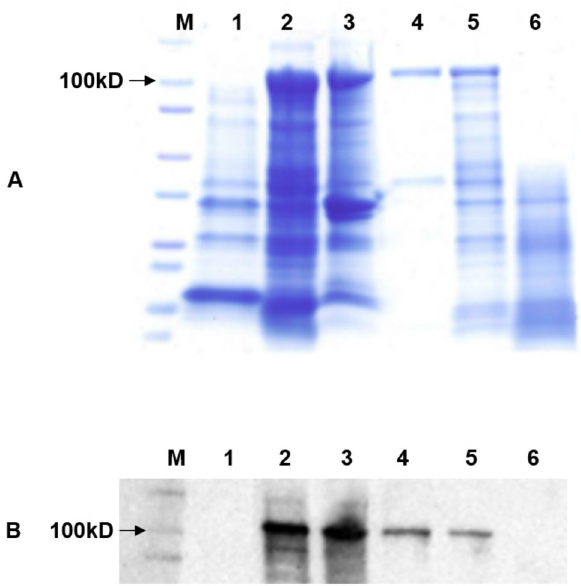
Figure 2. Polar localization of Las autotransporters LasA Figure 1. Expression and outer membrane localization of a I and LasA from ‘ Candidatus Liberibacter asiaticus’ (Las) in novel autotransporter protein, LasA , of ‘ Candidatus II I E. coli . A , D , G : GFP expression detected by confocal laser Liberibacter asiaticus’ (Las). SDS-PAGE ( A ) and Western scanning microscopy (CLSM) in E. coli containing recombinant blot ( B ) analysis of E. coli containing the pET102- lasA I plasmids pET102- gfp , pET102- gfp - lasA -TD and pET102- gfp - construct. M: A molecular mass marker; lane 1: Whole-cell I lasA , respectively. A , D , G : 505 nm LP filter; B, E, H : lysate from E. coli BL21 containing plasmid pET102 alone; lane II differential interference contrast (DIC) of bacterial cells; C, F, I : 2: Whole-cell lysate from E. coli BL21 containing recombinant FITC-DIC merged. plasmid pET102- lasA lane 3: outer membrane protein, lane 4: I, doi: purified LasA from whole-cell pellet, lane 5: LasA protein I I without proteinase K treatment, Lane 6: LasA with proteinase I K treatment.